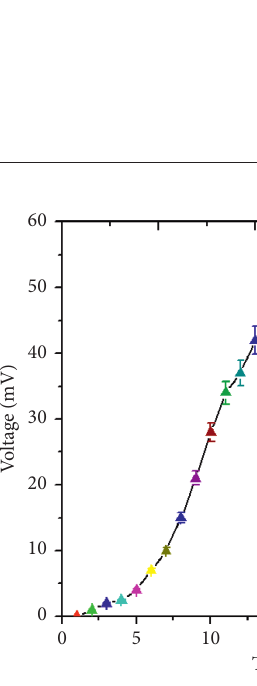
Figure 1: Voltage generation trend in the presence of mango extract as the substrate in MFC